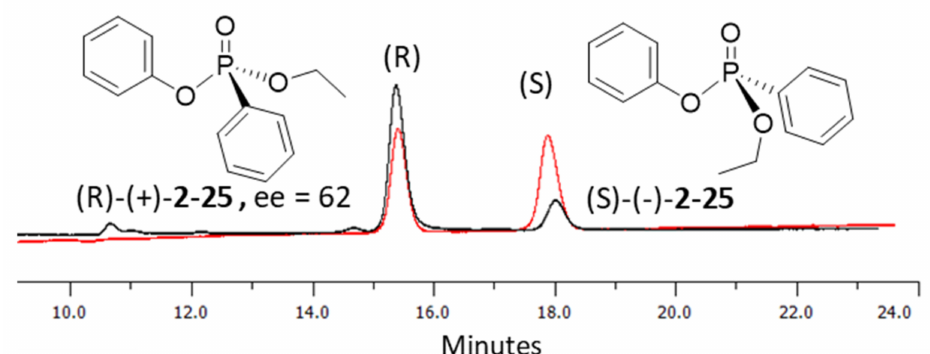
Figure 2. HPLC chromatograms of racemic (red) and chiral phosphonate analogues (black) of 30 using ( S )- 21 . Conditions. Phenomenex Lux amylose-2 chiral column (250 × 4.6 mm), eluent = hexane: ethanol (15:95 to 20:80) with 0.1% TFA, detection = 254 nm, flow rate = 0.5 mL/min, temperature = 25 ◦